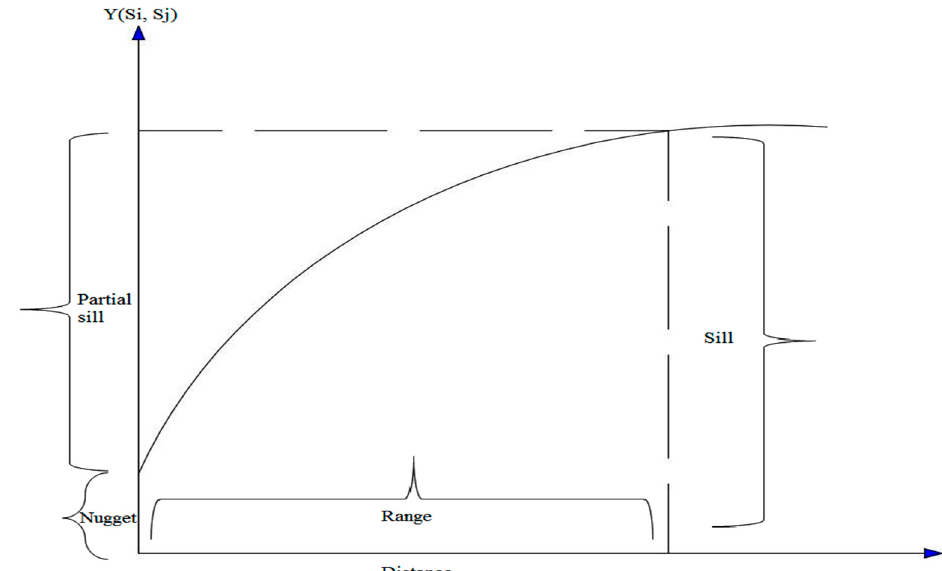
Figure 2. Attributes of a semivariogram model adapted from [13]. NB: Sill refers to the value that the semivariogram model attains at the range; the nugget effect can be attributed to measurement errors or spatial sources of variation at distances smaller than the sampling interval or both; the partial sill is the sill minus the nugget; and range refers to the distance value where the model first flattens out.